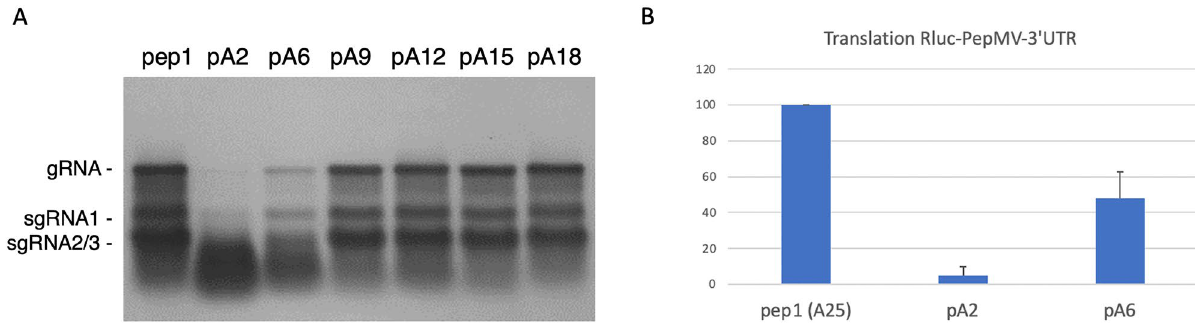
Figure 3. The effect of polyA tail length on the replication of PepMV. ( A ) Northern blot showing the accumulation of PepMV gRNA and sgRNAs in N. benthamiana protoplasts. pep1: wt PepMV with A25, A2, A6, A9, A12, A15, A18. The migration of gRNA and sgRNAs is indicated. We note that sgRNA2 and 3 comigrate on these gels. ( B ) Effect of polyA tail length on translation efficiency of the PepMV-3 ′ UTR in protoplasts. Error bars indicate standard deviation of 2